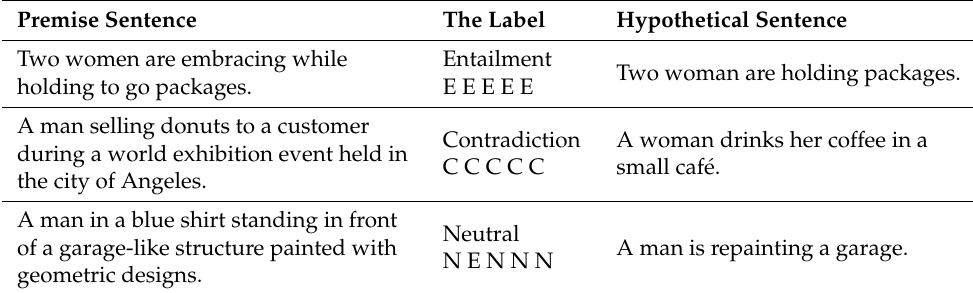
Table 1. Sample data of SNLI dataset.